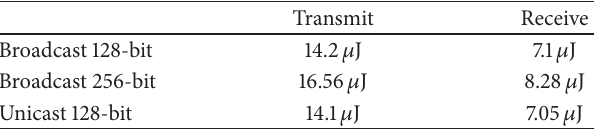
Table 1: Energy consumption of a MICAz sensor